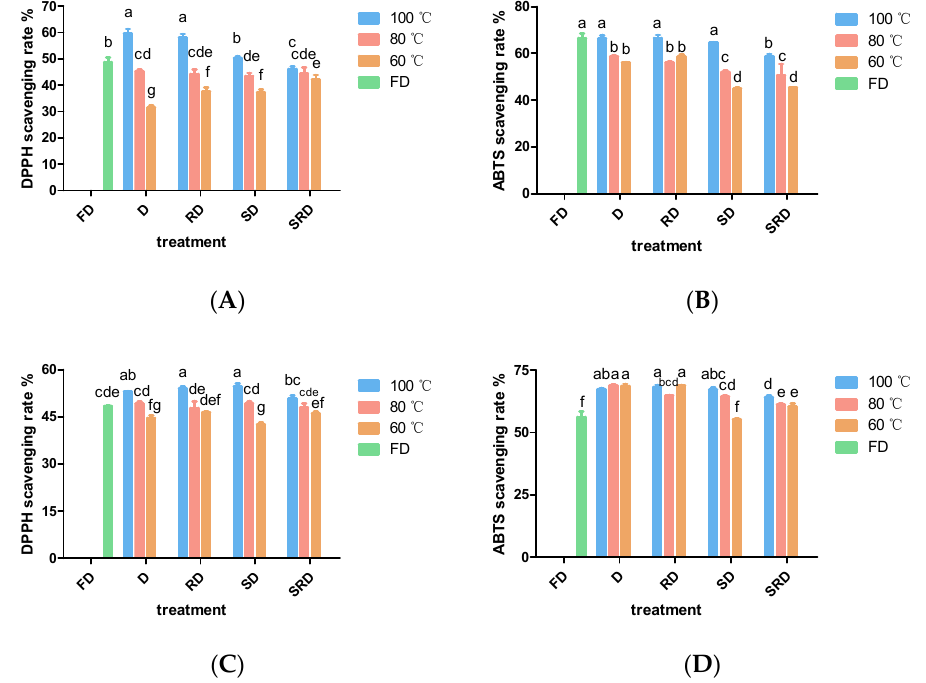
Figure 2. Antioxidant activities of Dendrobium catenatum (0.02 g·mL − 1 dried weight) are shown after exposure to various processing methods: ( A ) DPPH·-scavenging rate of 80% methanol extract, ( B ) ABTS + -scavenging rate of 80% methanol extract, ( C ) DPPH·-scavenging rate of water extract, and ( D ) ABTS + -scavenging rate of water extract. Columns represent the mean ( n = 3) ± standard deviation. Columns of the same shape with different letters indicate significant differences ( p < 0.05).